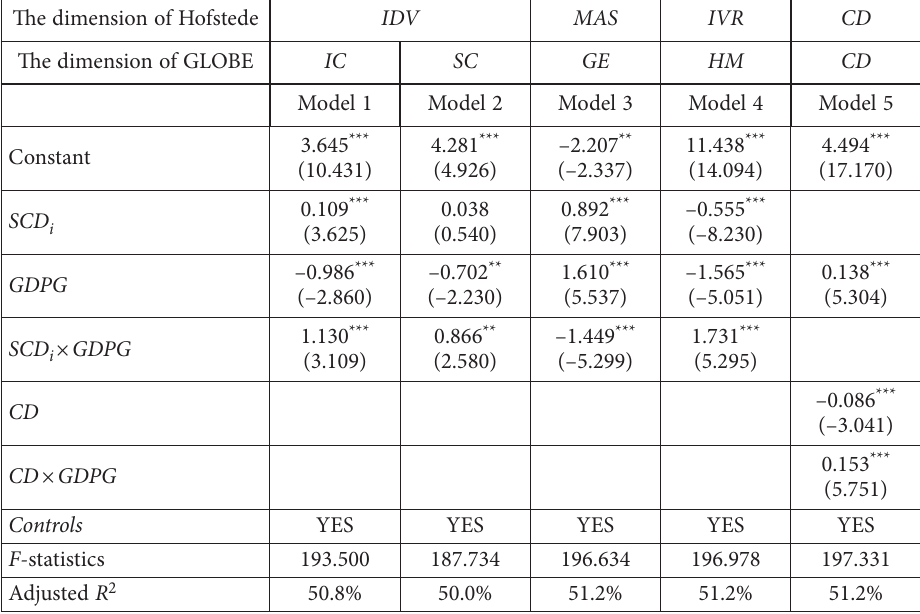
Table 7. The moderating effect of economic growth on GLOBE cultural dimensions and IPO underpric- ing (source: authors’ calculation) The dimension of